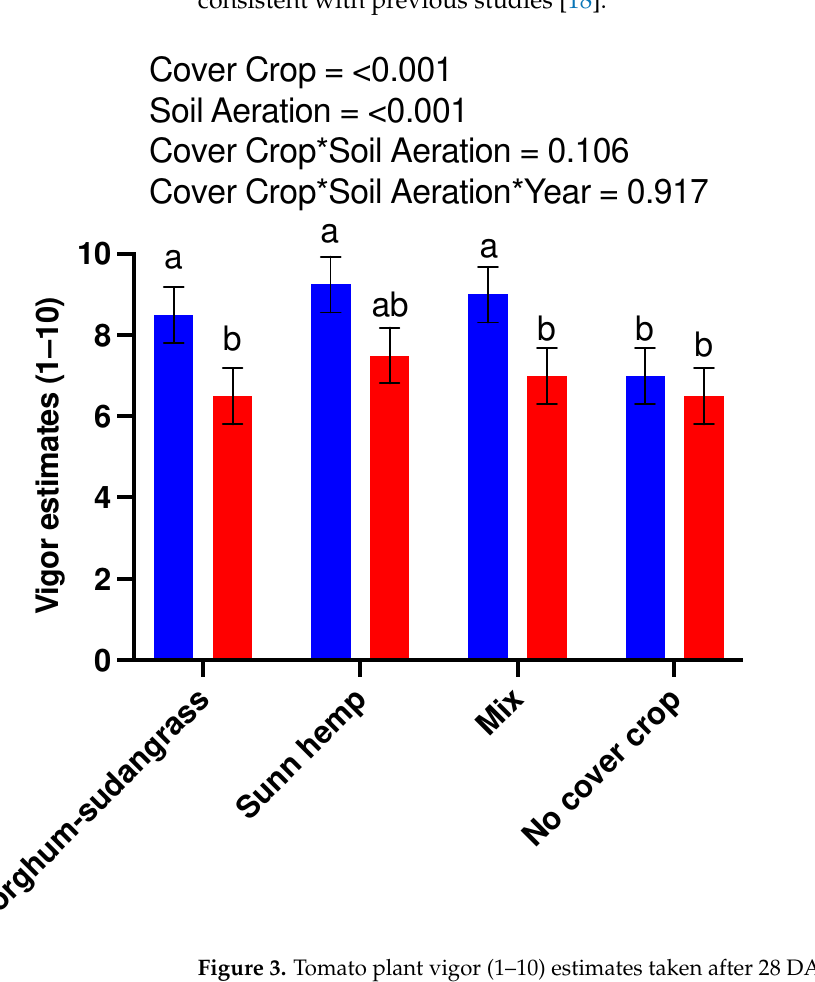
Figure 3. Tomato plant vigor (1–10) estimates taken after 28 DAT (days after transplantation) in 2020 and 2021 field plots amended with cover crops [sorghum-sudangrass, sunn hemp, mix (sorghum- sudangrass + sunn hemp)] in two soil conditions (non-aerated or aerated). Data are pooled for both years because there was no cover crop*soil aeration*year interaction; (*) in text indicate interaction and on p values indicate significant effects. Data are expressed as mean ± SD (n = 8); bars with the same letter indicate the means are not significantly different based on the least significant difference (LSD) test ( p < 0.05). The experiment was conducted at the organic research farm, Clemson University Coastal Research and Education Center (CREC), Charleston, SC,